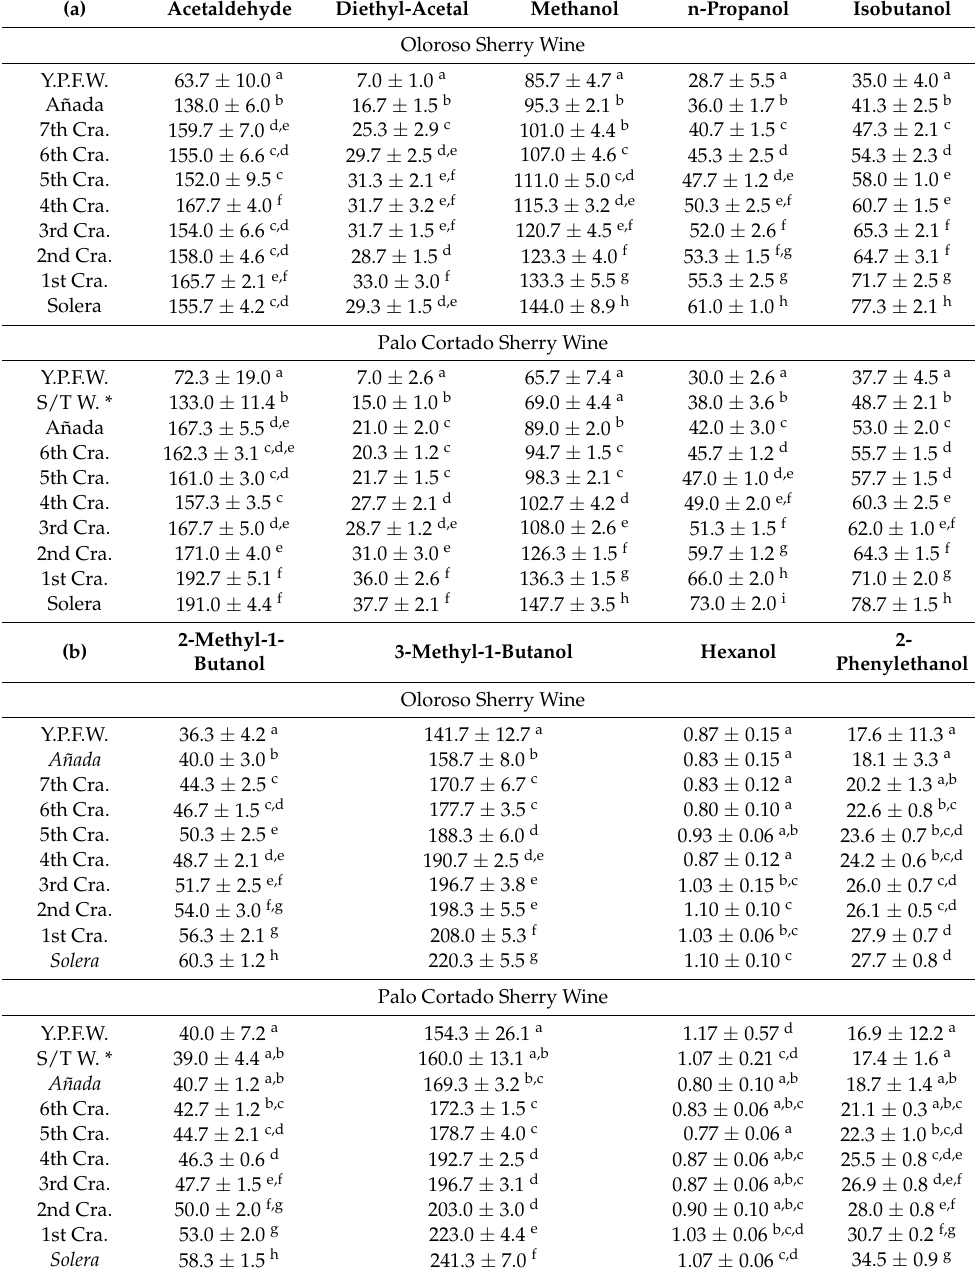
Table 6. (a) Acetaldehyde, acetaldehyde-diethylacetal, methanol and higher alcohols in mg/L in the Oloroso and Palo Cortado Sherry wines studied. (b) Higher alcohols, in mg/L, in the Oloroso and Palo Cortado Sherry wines